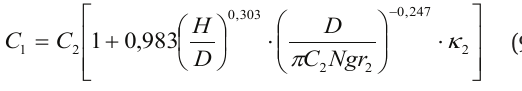
Table 2. Comparison of the M-K approximation of piles 1 and 8 in